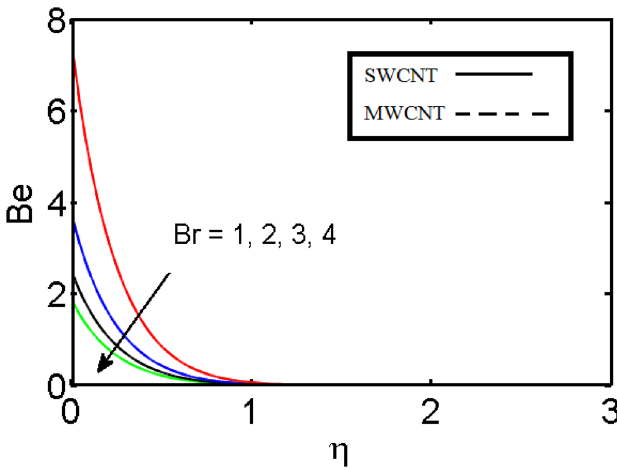
Figure 11. Illustration of Bejan number Be for different values of Br .